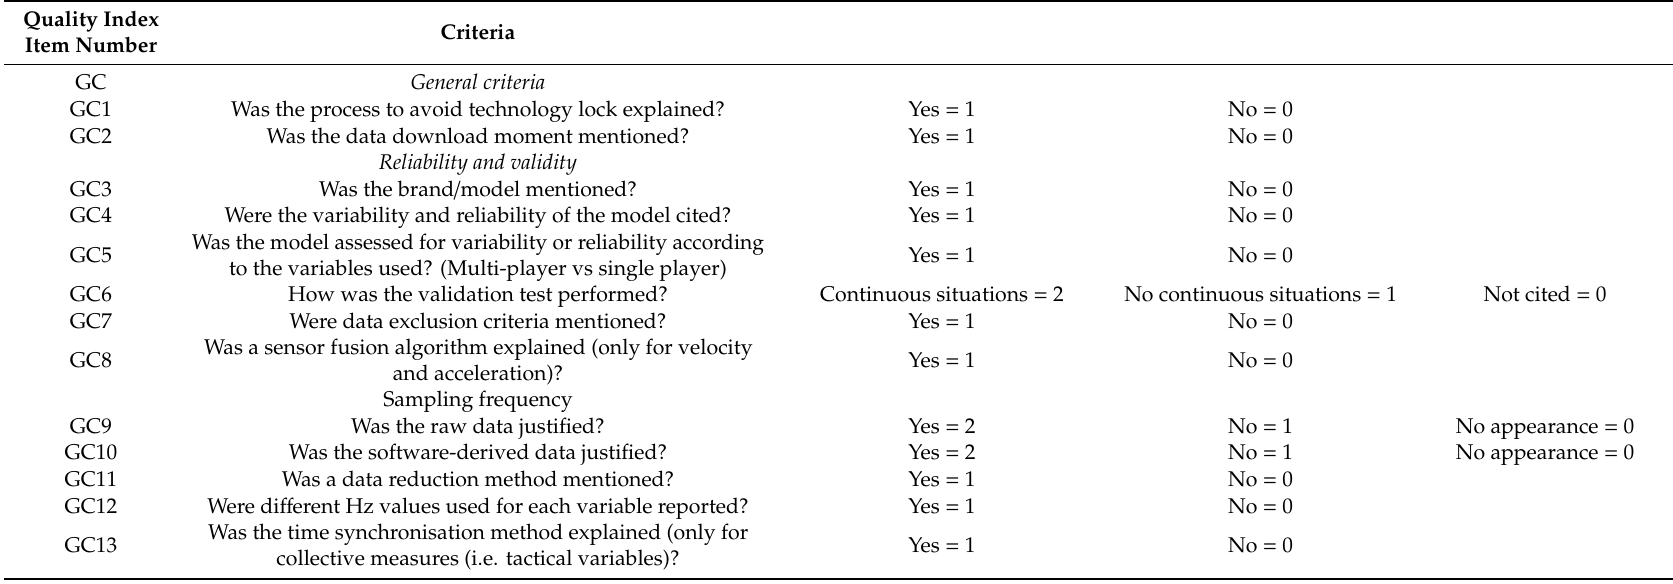
Table 1. Check sheet for assessing external workload and collective variables using radio-frequency technologies (i.e., GPS / GNSS and LPS) in